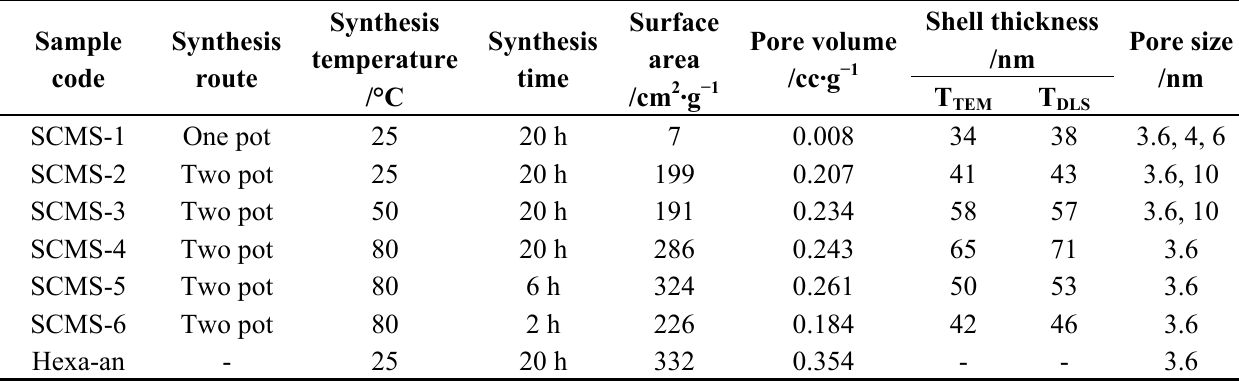
Table 1. Synthesis conditions and textural parameters for core-mesoporous shell silica spheres prepared by anionic